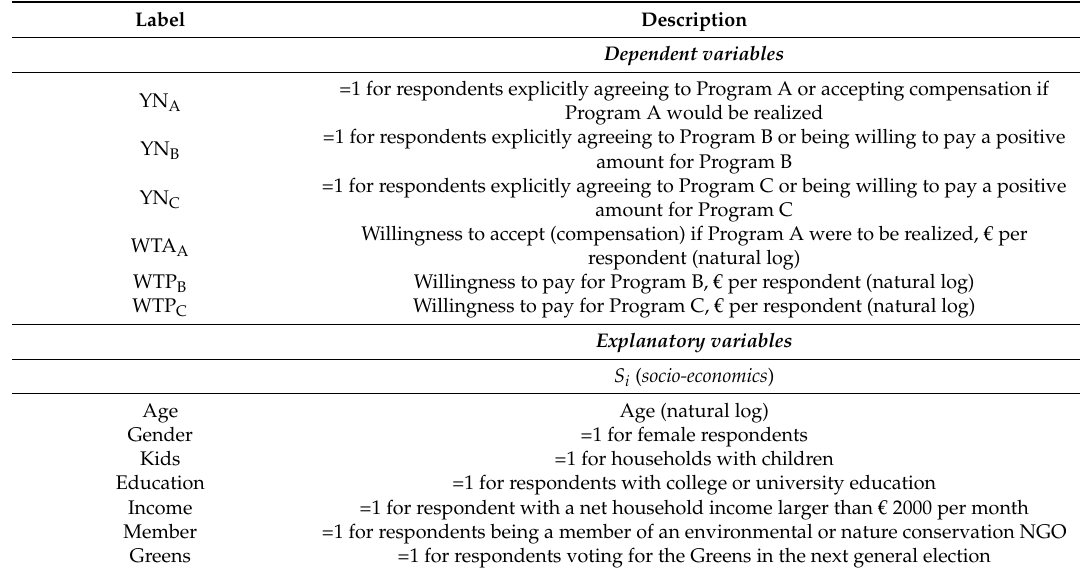
Table 1. Overview of the variables of the descriptive and econometric